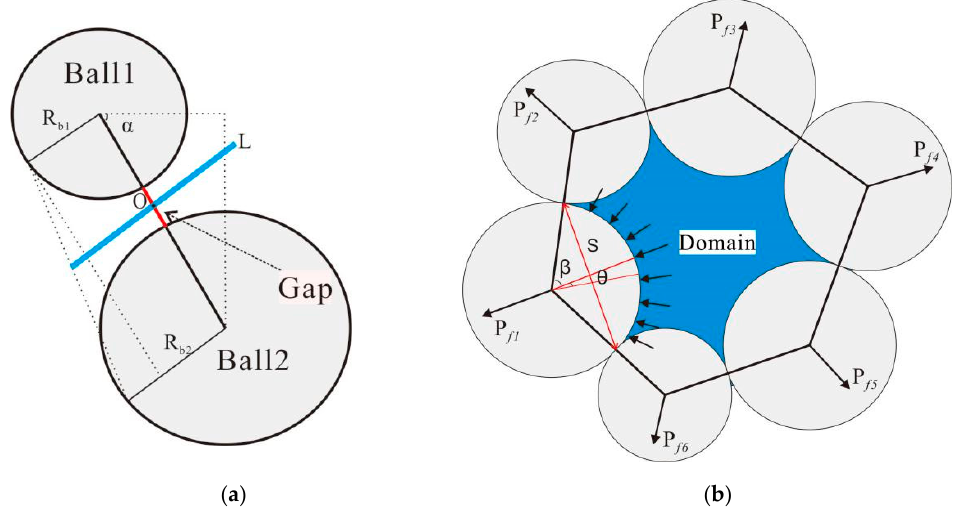
Figure 2. Length and position of fluid passage: ( a ) length and position of fluid pipe and ( b ) fluid-particle interaction mechanism.